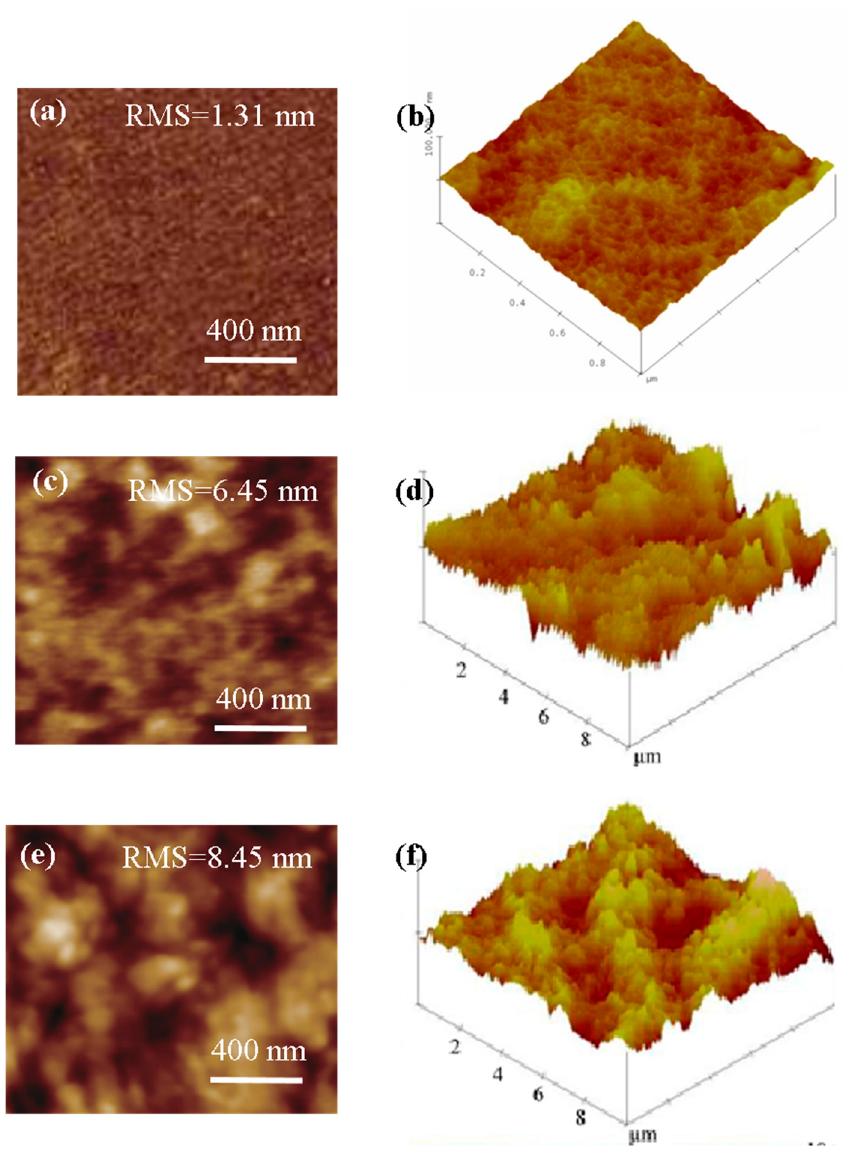
Figure 5. AFM images of the mixed matrix membranes (2D images and 3D images of membrane surface of ( a , b ) M-0, ( c , d ) M-15 and ( e , f ) M-25).